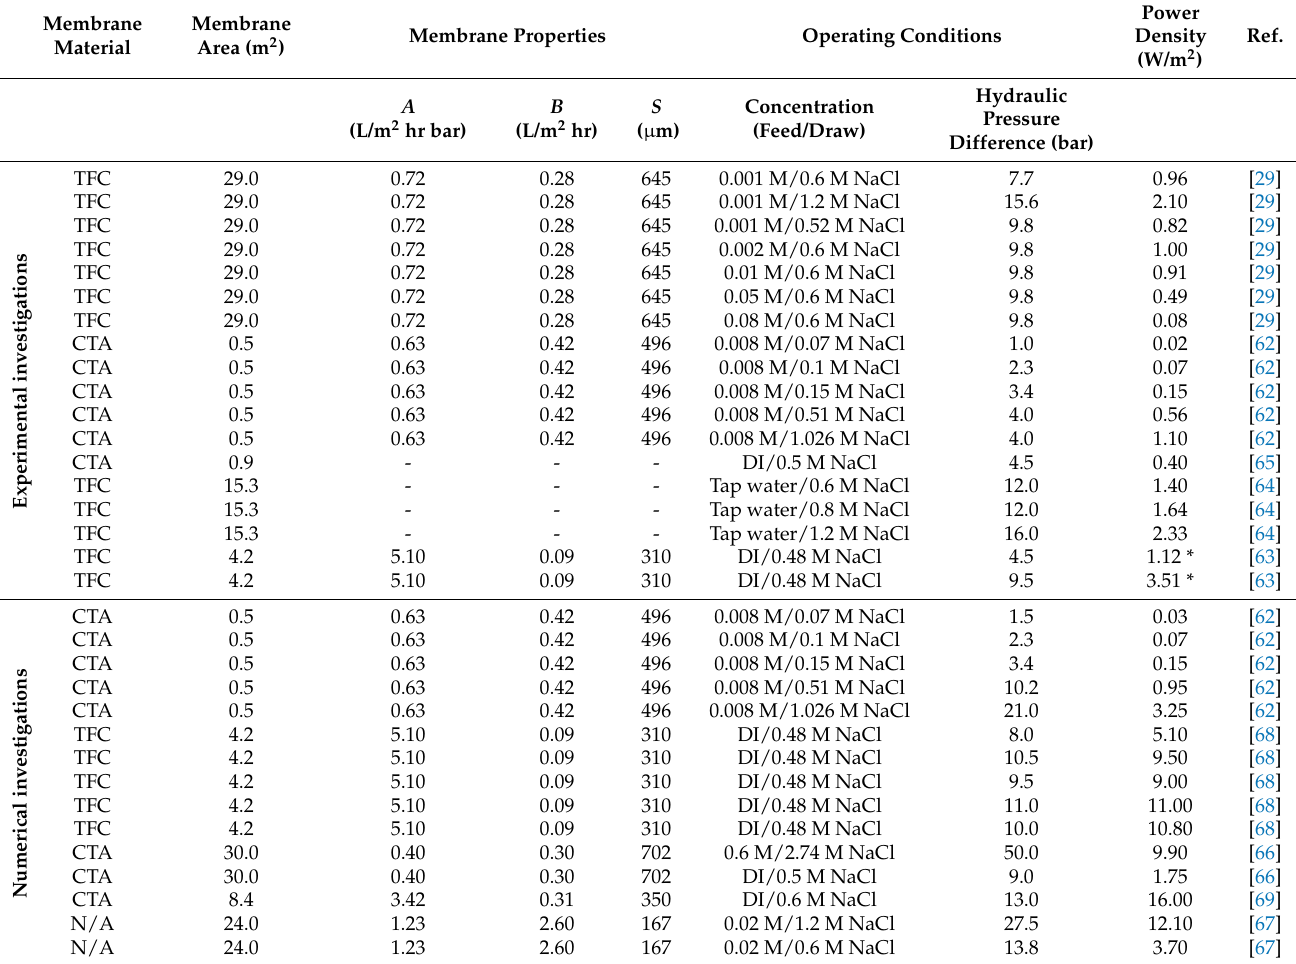
Table 3. Performance and key properties for commercially available membranes in a spiral wound module from both experimental and numerical